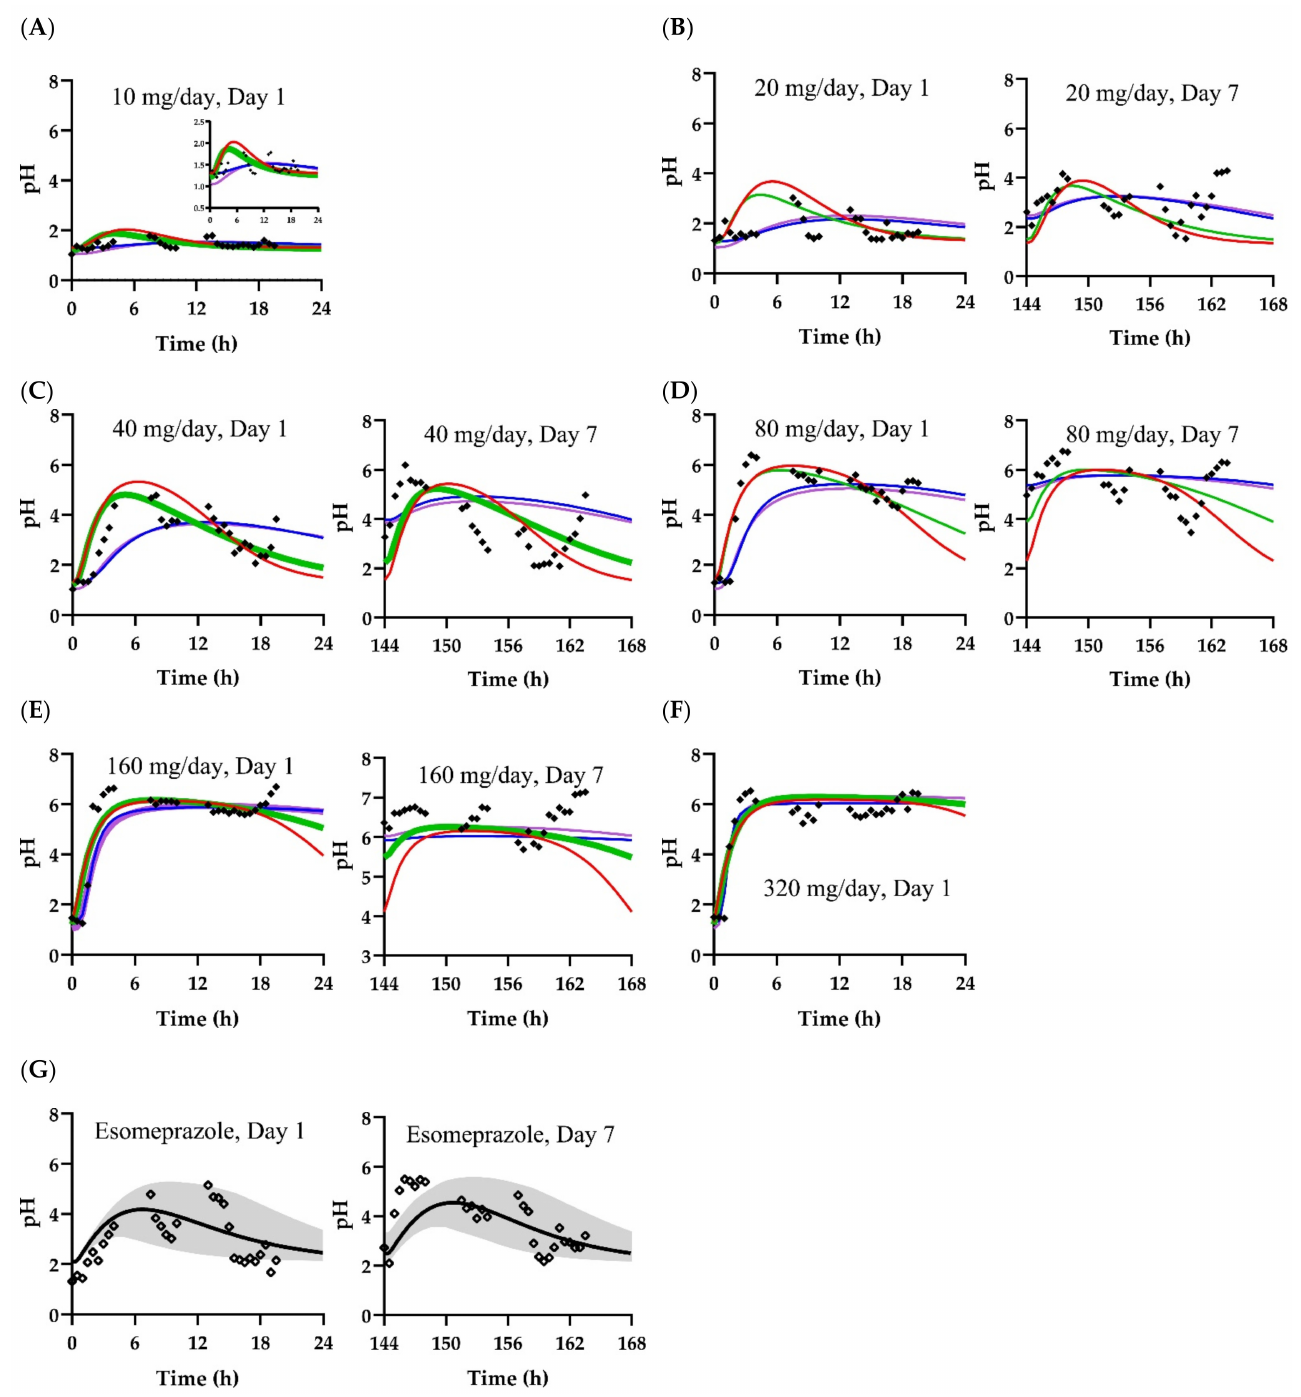
Figure 3. Gastric pH after oral fexuprazan and esomeprazole administration. Closed diamonds ( ) ◆ ) represent observed pH after the oral administration of 10 ( A ), 20 ( B ), 40 ( C ), 80 ( D ), 160 ( E ), and 320 mg fexuprazan QD ( F ). Open diamonds ( ◇ ) represent observed pH after the administration of 40 mg QD esomeprazole ( G ). Red and green lines represent simulated pH profiles for the PK–PD model using unbound plasma concentrations in the one-compartment (Scenario A) and PBPK (Sce-nario B) models, respectively. Blue and purple lines are simulated pH using the indirect (Scenario C) and direct PD (Scenario D) models, respectively. Black lines are the medians of simulated pH among the virtual population through the indirect model incorporating unbound plasma